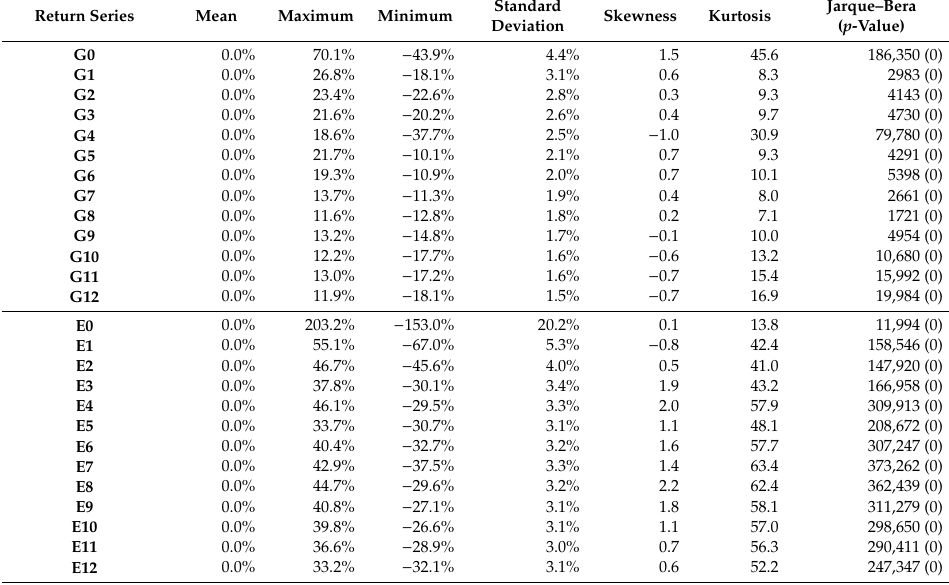
Table 1. Summary statistics of each return series of natural gas and electricity prices.